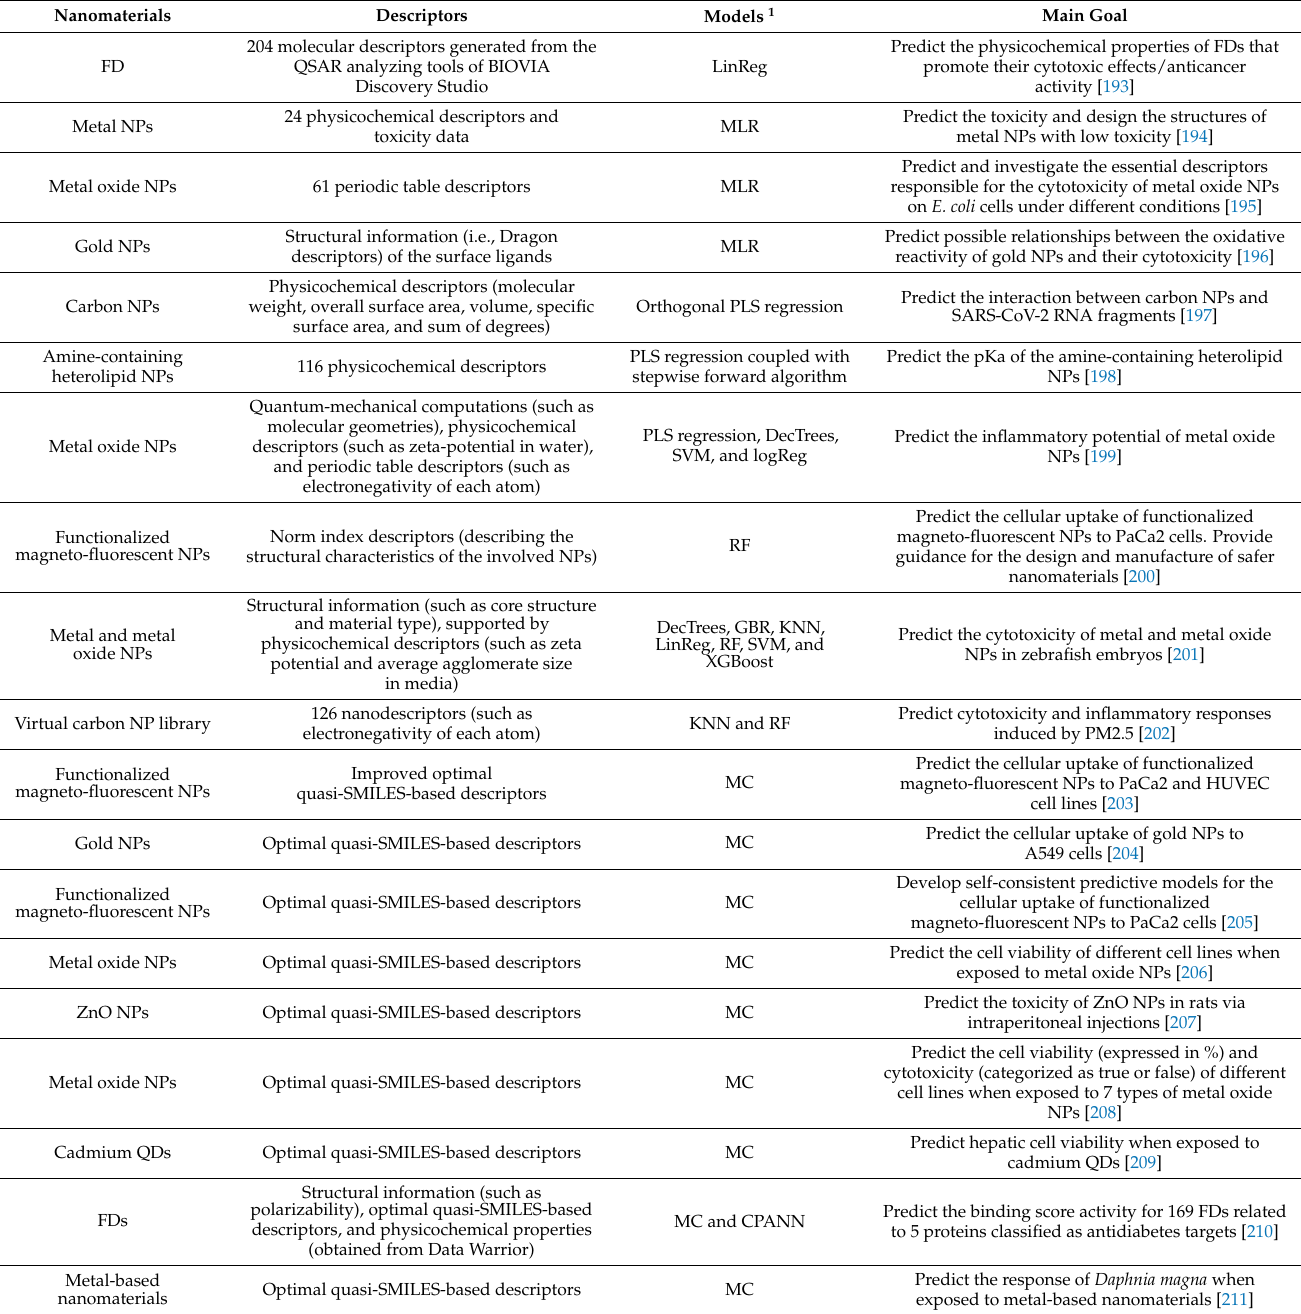
Table 5. Overview of the most recent nanotoxicology predictive models. A PubMed search for “QSAR and nanoparticles” from 2020 to 2022 was performed in April 2022. No other filters were